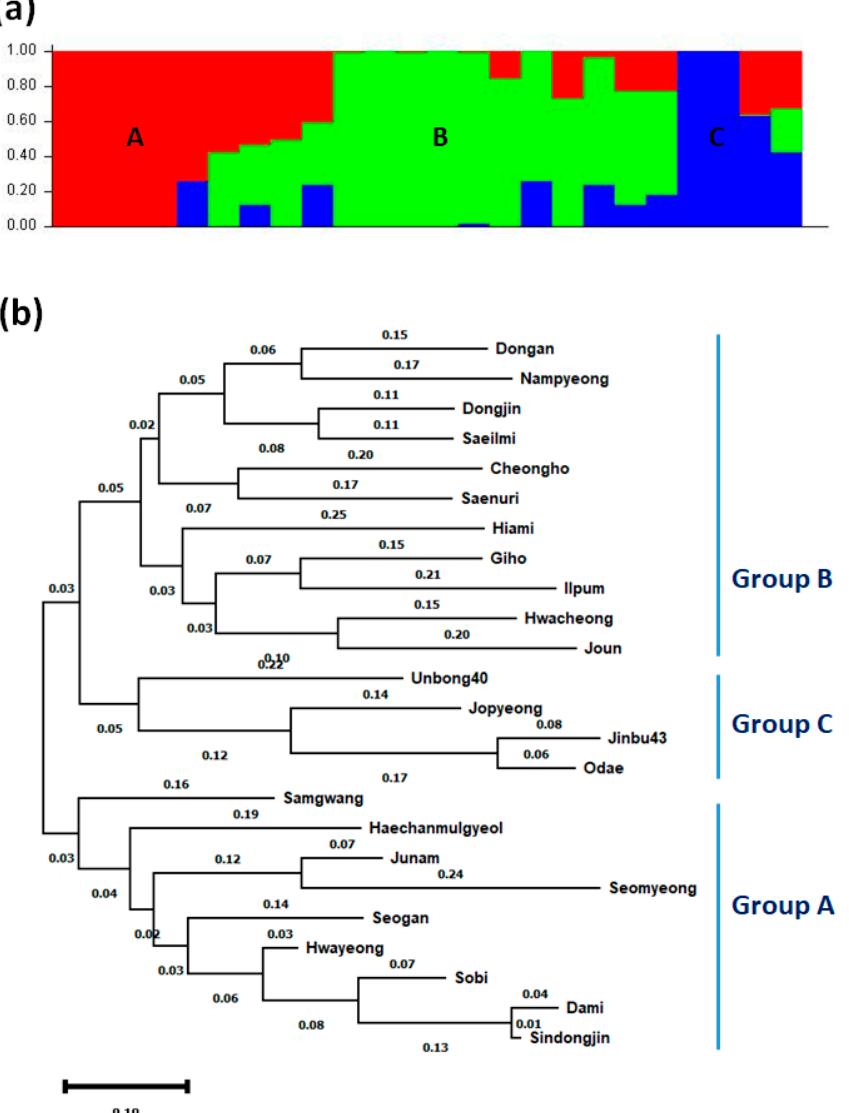
Figure 4. Structure and phylogeny analysis of 24 Korean temperate japonica rice varieties. ( a ) Assignment of 24 Korean temperate japonica rice varieties into three populations (A, B, and C) using STRUCTURE 2.3.4 software. The different colors represent different populations. ( b ) Phylogenetic tree of 24 Korean temperate japonica rice varieties. The phylogenetic tree was inferred using the maximum likelihood method and Tamura – Nei model. The tree with the highest log likelihood is shown.